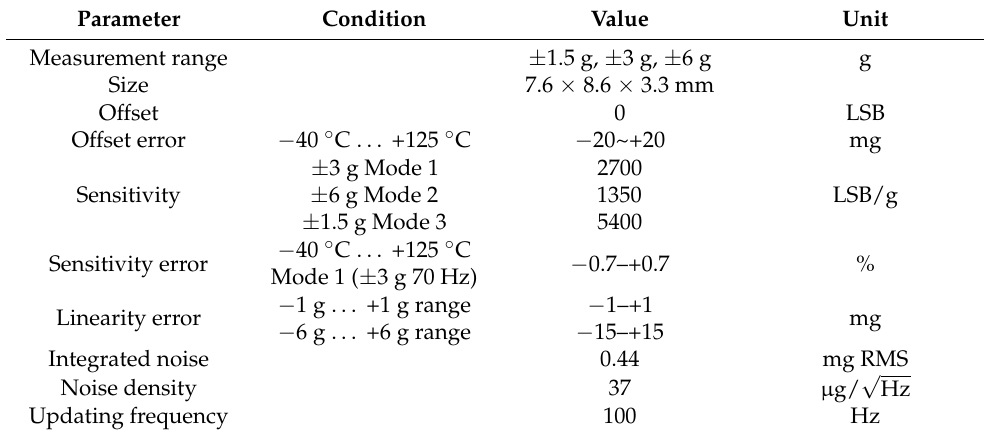
Table 1. Principal specifications of GNSS and accelerometer.